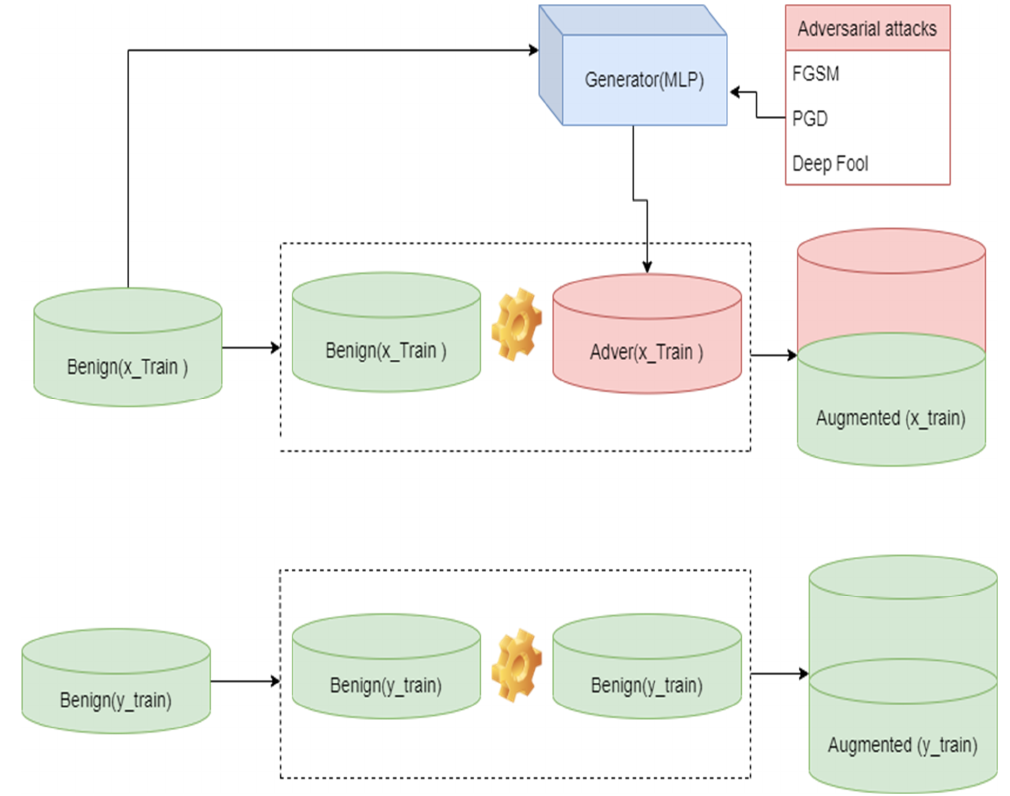
Figure 7. Heuristic data augmentation.